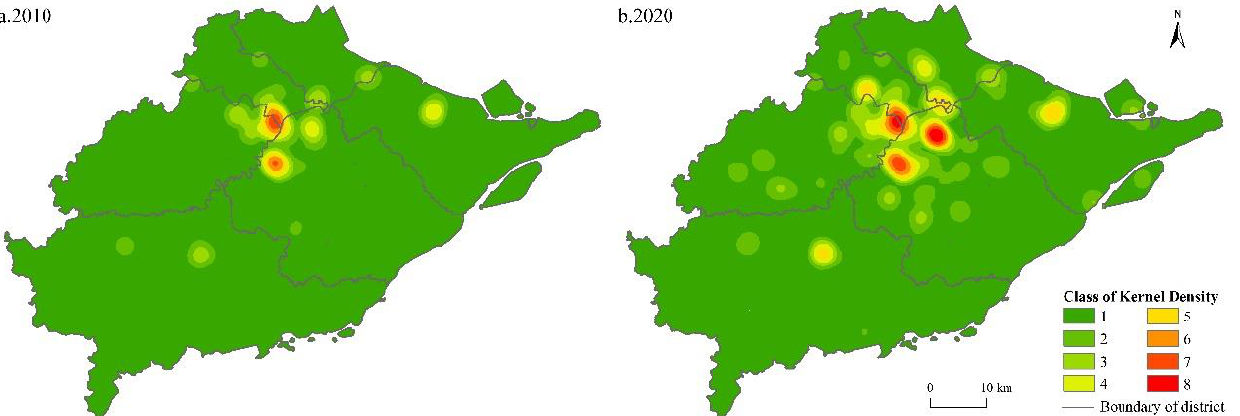
Figure 3. Kernel density of cultural facilities in the central district of Ningbo in ( a ) 2010 and ( b ) 2020. Note: This map is based on the standard map of the Map Technical Review Centre of the Ministry of Natural Resources of China (Number: Zhejiang S (2022)34), with no modifications to the base map. Map-making by the